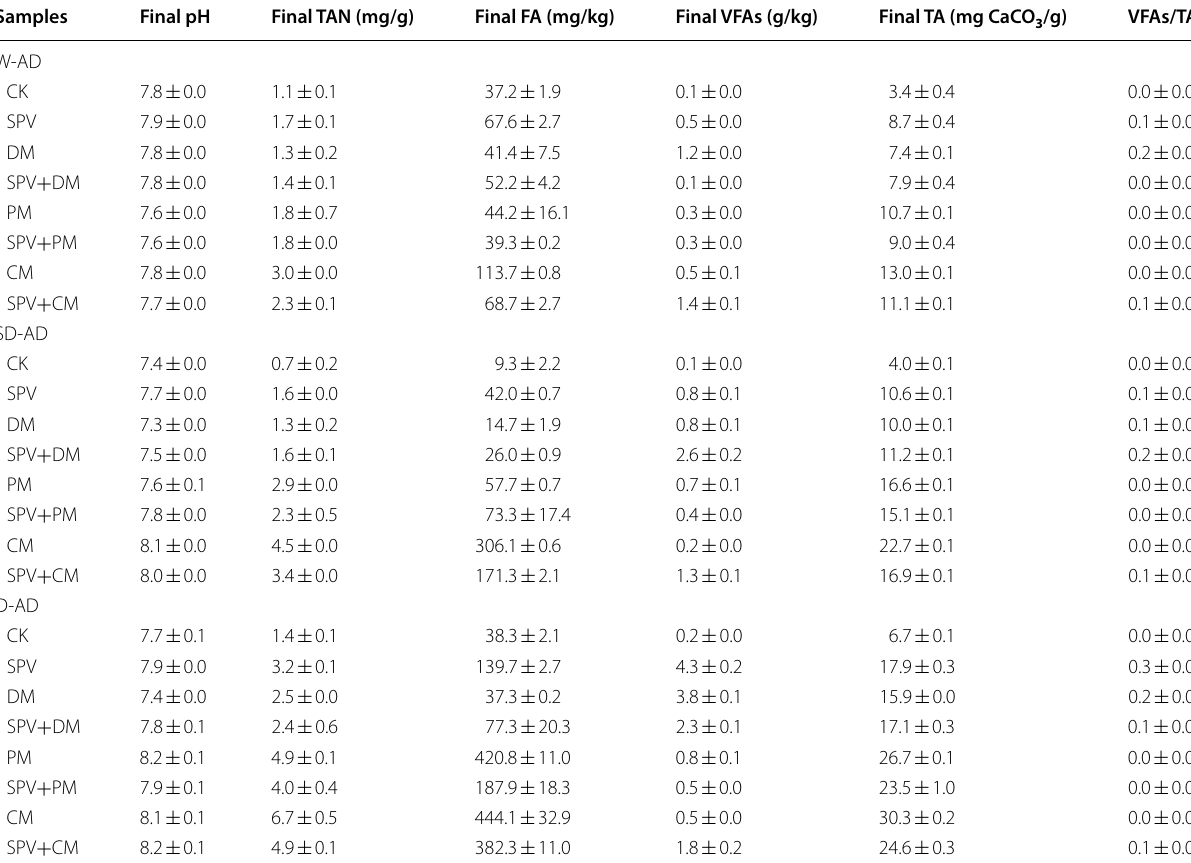
Table 3 Characterization of digestate from different mixtures of SPV and animal manure in various anaerobic conditions